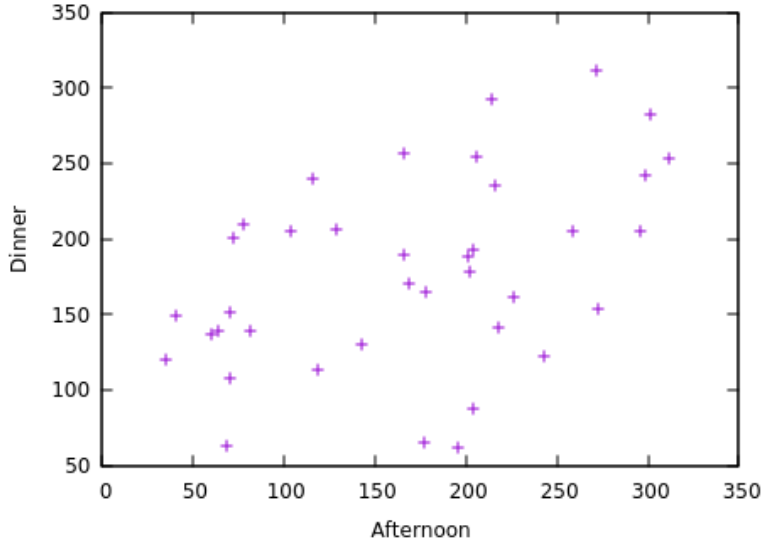
Figure 2. Scatter plot of a measurement in the afternoon and at dinner on the same day.